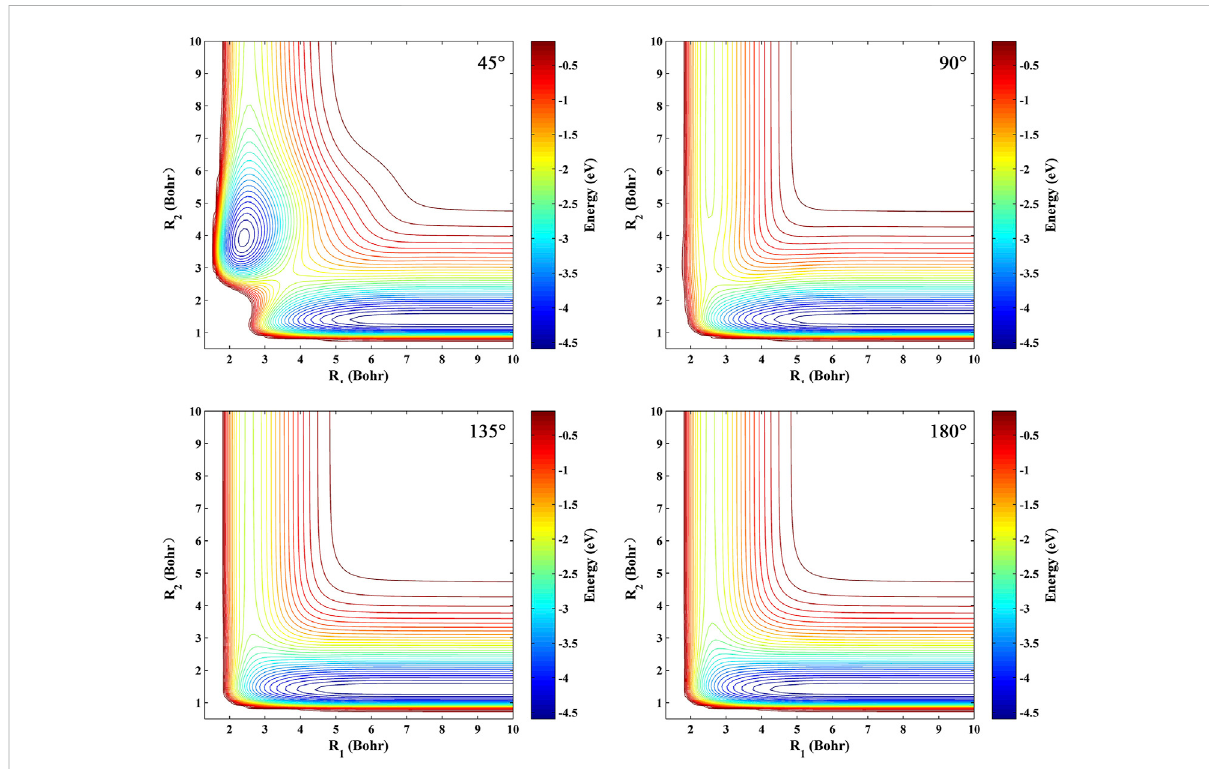
FIGURE 4 Contour plots of the ground-state BeH 2 PES at four Be-H-H angles (45 ° , 90 ° , 135 ° , and 180 ° ).